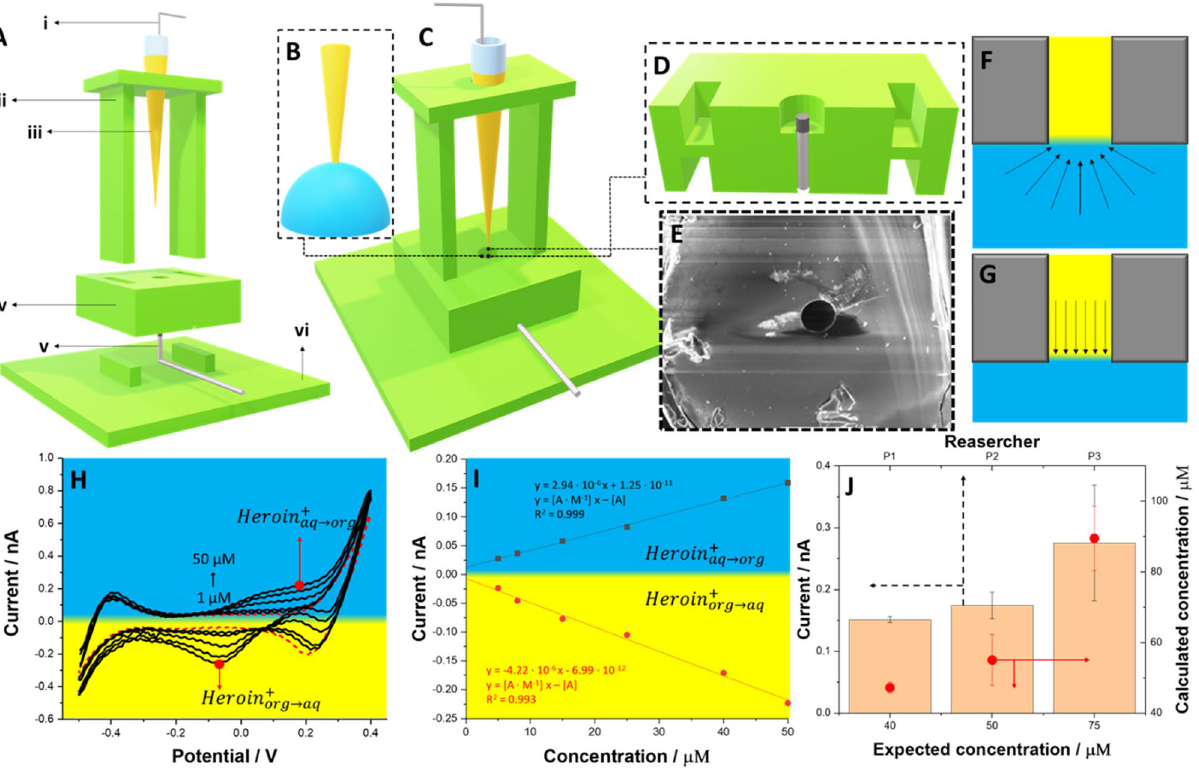
Figure 4. ( A ) – The sequential representation of the 3D printed platform used for the heroin detection in microliter volume droplet: ( i ) – is the Ag/AgTPBCl reference and counter electrode (in one) of the organic phase; ( ii ) is the support with pre-adjusted height hosting the tip filled with the ( iii ) organic phase; ( iv ) is the cell middle part with the opening for the droplet deposition; ( v ) is the Ag/AgCl electrode serving as the reference and counter electrode (in one) of the aqueous phase; ( vi ) is the printed platform support assuring entire cell stability. ( B ) – Zoom into the end of the tip filled with the organic phase immersed into the aqueous phase. ( C ) – Assembled platform. ( D ) – Cross section of the cell middle part ( iv ) showing the position of the ( v ) Ag/ AgCl electrode. ( E ) – SEM micrography of the fused silica capillary pore having 25 µm diameter. ( F ) – Scheme showing the mass transfer from the aqueous to the organic phase governed by hemispherical diffusion. ( G ) – Scheme showing the mass transfer from the organic to the aqueous phase governed by linear diffusion. ( H ) – Series of CVs recorded at the microscopic LLI supported with fused silica capillary tubing for the increasing concentration of heroin (from 1 to 50 µM) in the presence of fixed [paracetamol] and [caffeine] = 500 µM (red dash line is CV recorded in the absence of heroin; pH = 5.5; scan rate = 20 mV·s −1 ). ( I ) – Calibration curves plotted based on the positive and negative peak currents deduced from part H. ( J ) – The chart showing the results of heroin detection from model formulations (bottom x, right y axes) together with repeatability test performed by three different persons (P1, P2, P3, upper x and left y axes). For axis meaning and details refer to the main text.